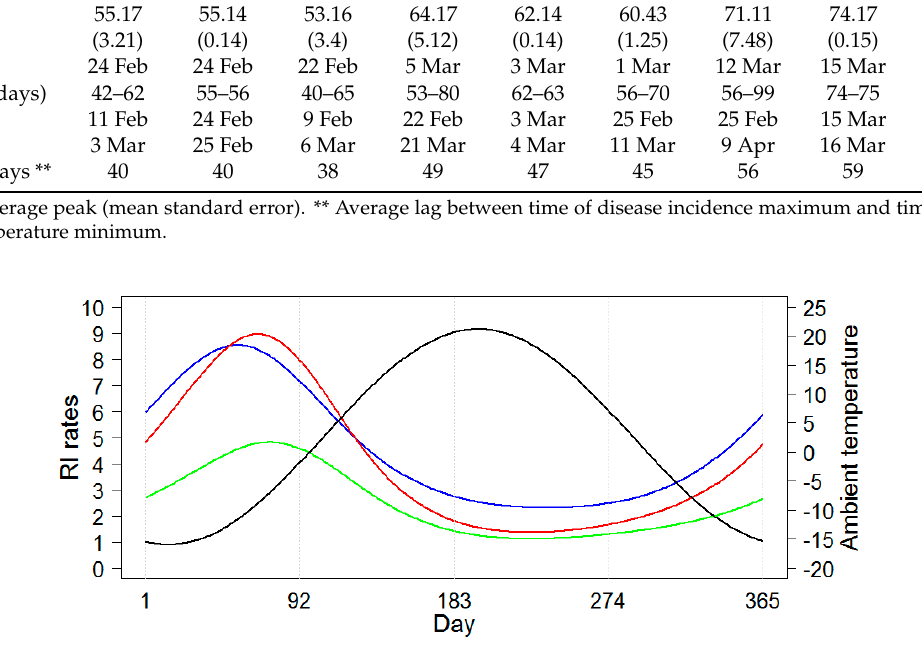
Figure 6. The average seasonal curves for daily time series rotaviral infection (RI) rate based on Model C’ for three cities, Chelyabinsk (blue line), Yekaterinburg (red line), and Barnaul (green line), and for the average daily temperature which was identical for all three cities (black line).